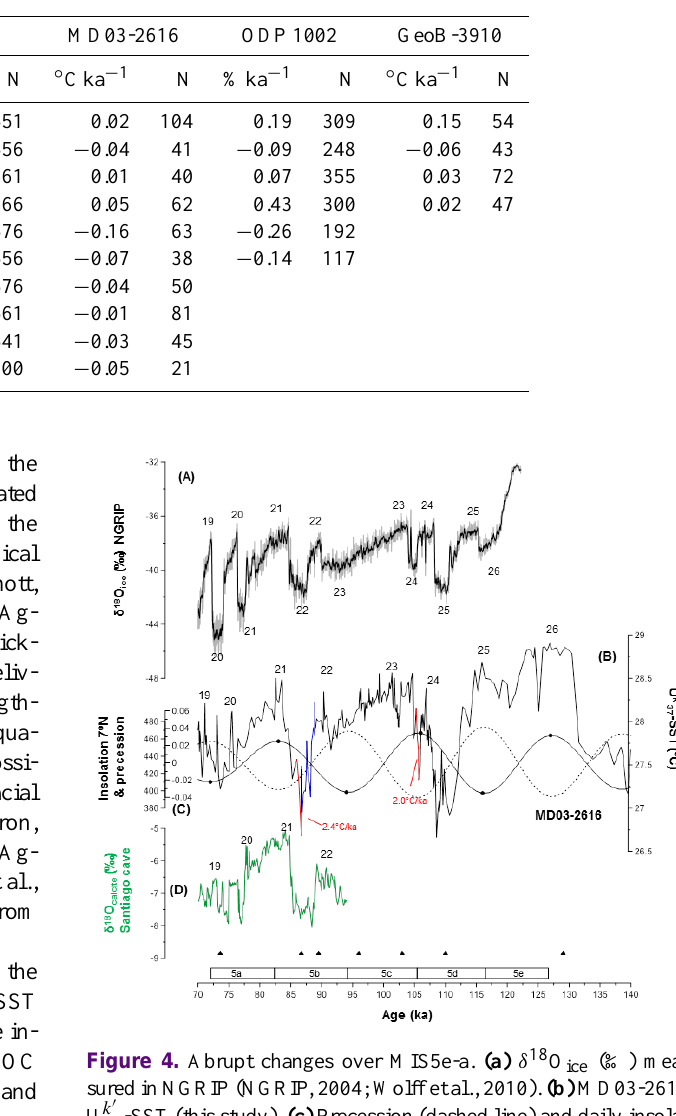
Table 2. Trends between precession maxima and minima and vice-versa (insolation minima and maxima and vice-versa) from the marine isotope stage – MIS5e to MIS2 in Greenland (NGRIP; North Greenland Ice Core Project members, 2004), Guiana Basin (MD03-2616; this study), Cariaco Basin (ODP 1002C; Peterson et al., 2000) and off north-eastern Brazil (GeoB-3910; Jaeschke et al., 2007). N refers to the number of samples used to calculate the trends.